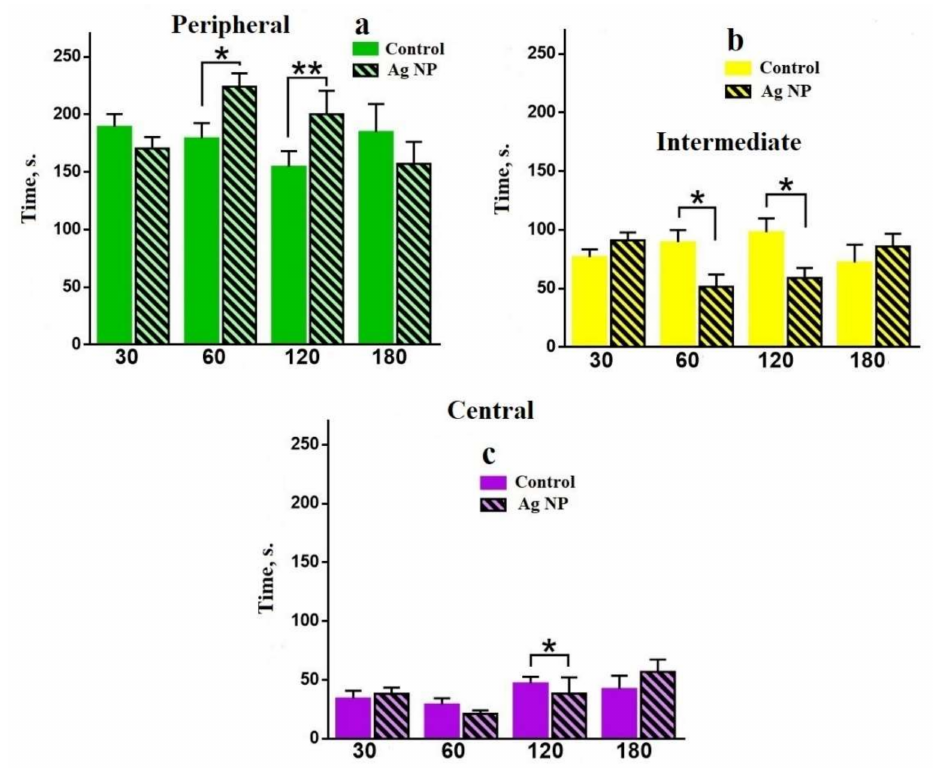
Figure 5. Time spent in the Peripheral ( a ); the Intermediate ( b ) and the Central ( c ) areas for different periods of the